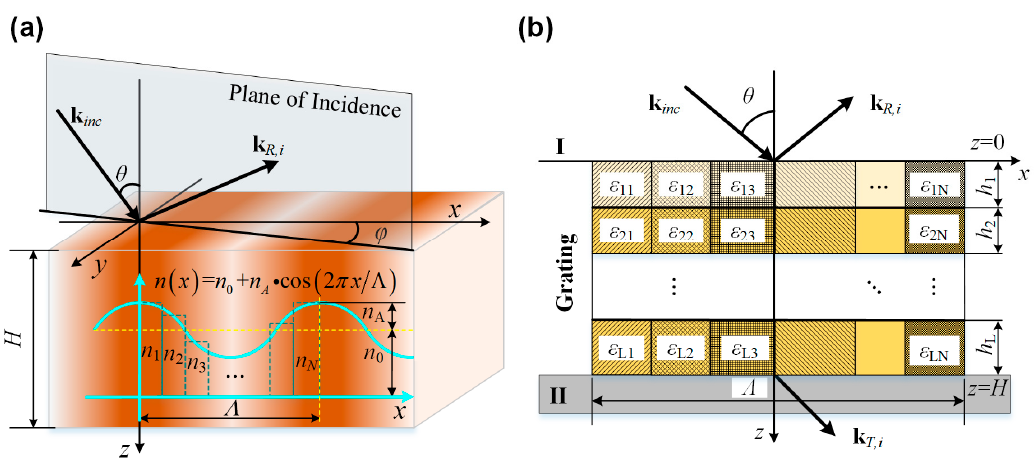
Figure 1. Scheme of the ( a ) spatial refractive index distribution in a volume grating; and ( b ) the corresponding distributed dielectric constant model used for rigorous coupled-wave analysis.